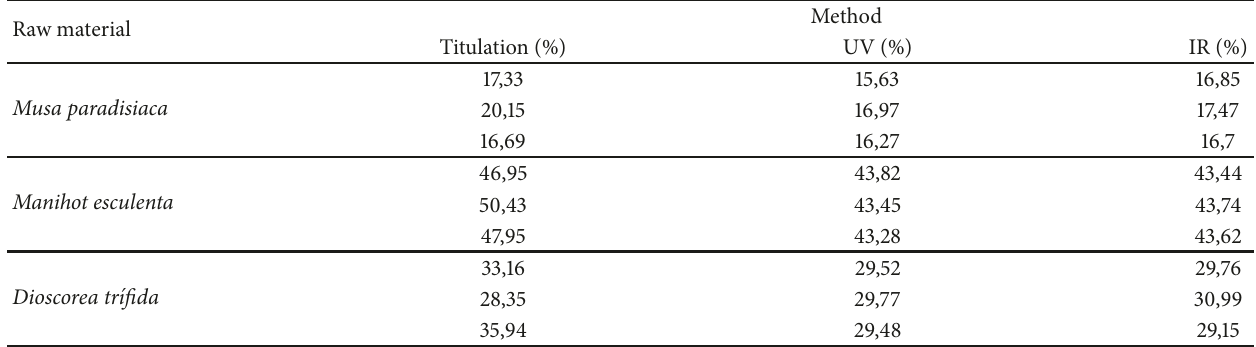
Table 2: Descriptive statistics for the percentage of starch with respect to the method and the raw material. Raw material